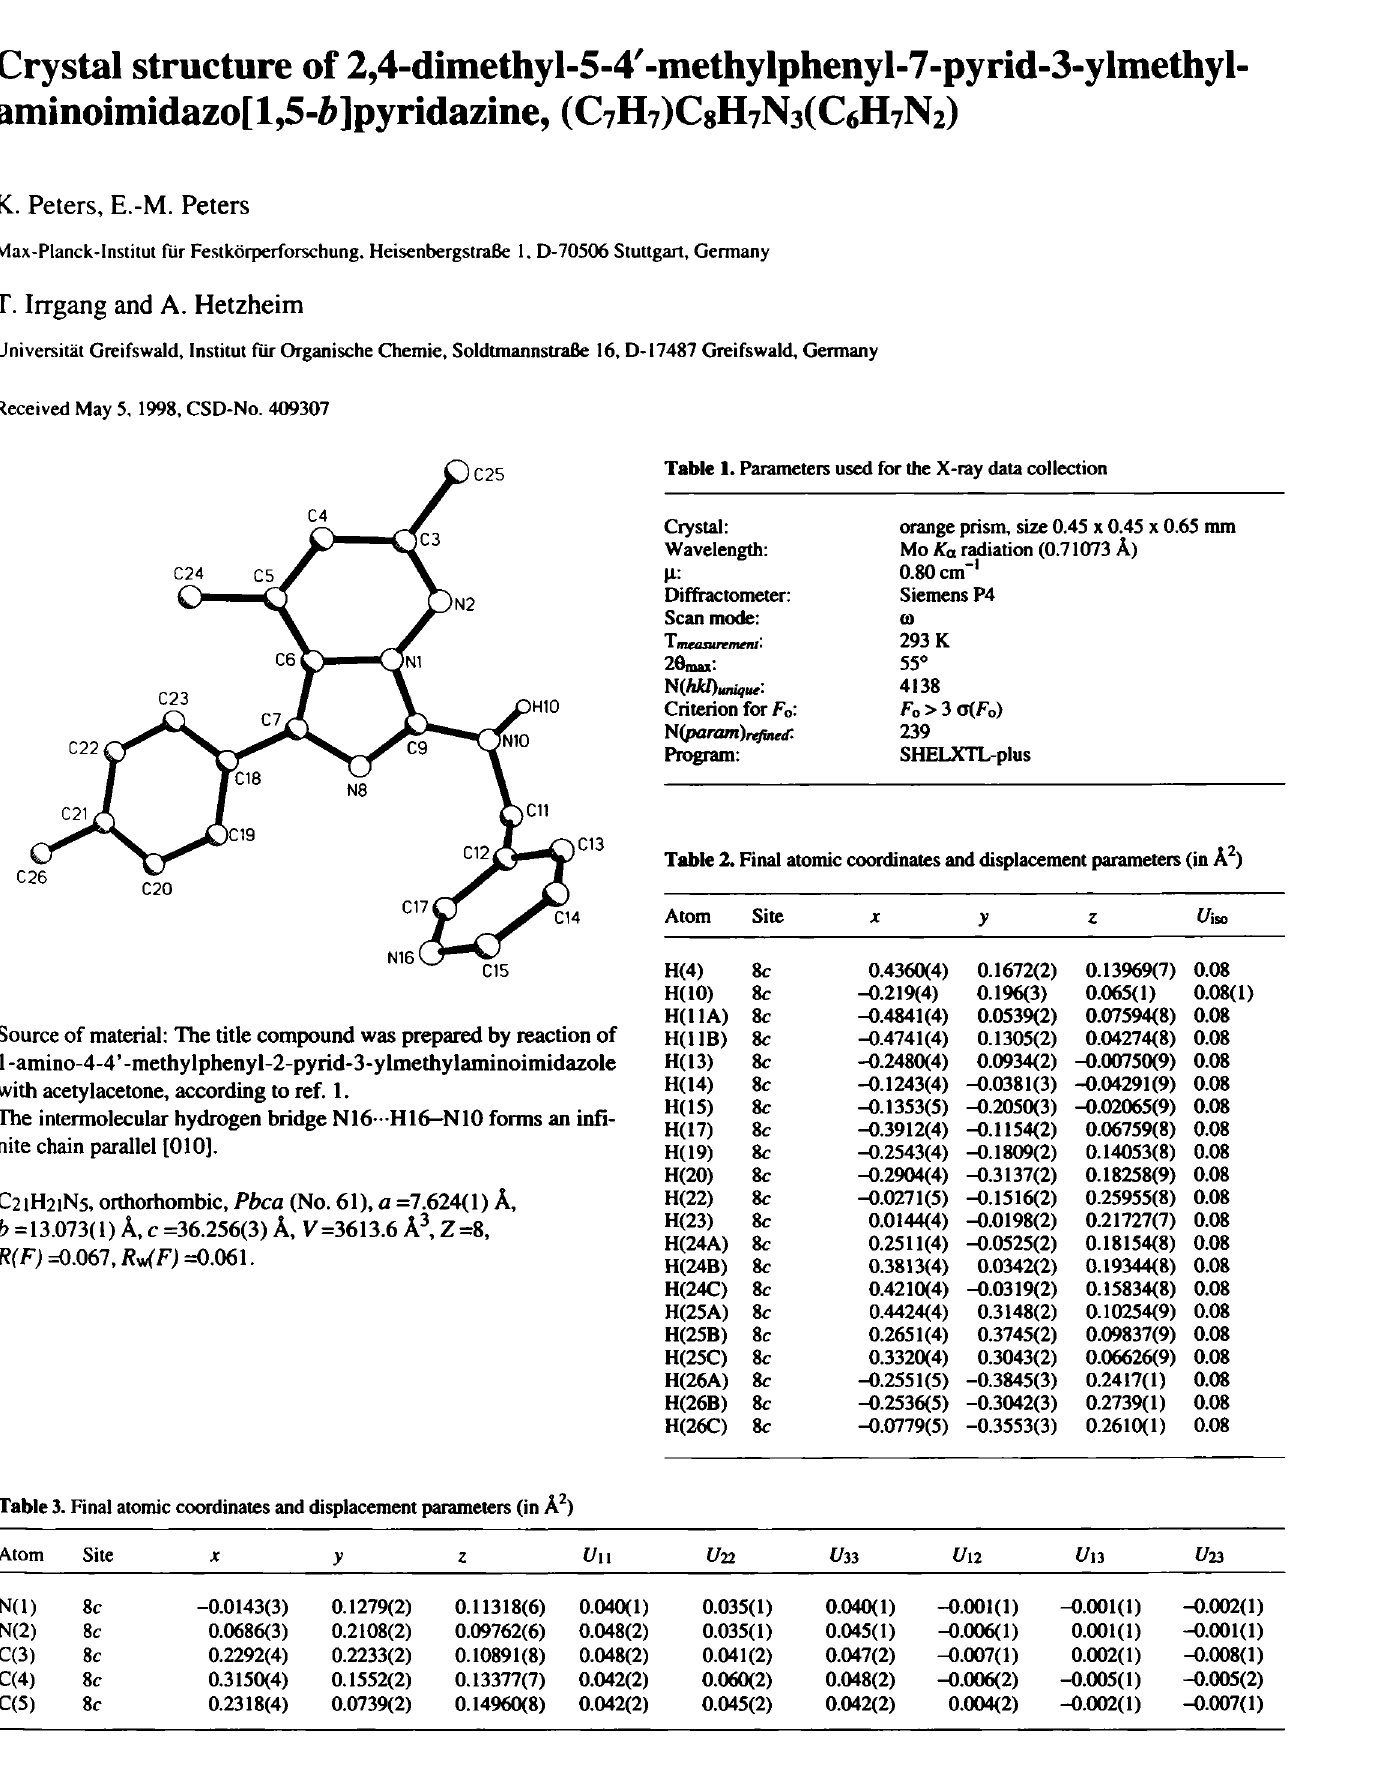
Table 3. Final atomic coordinates and displacemem parameters (in